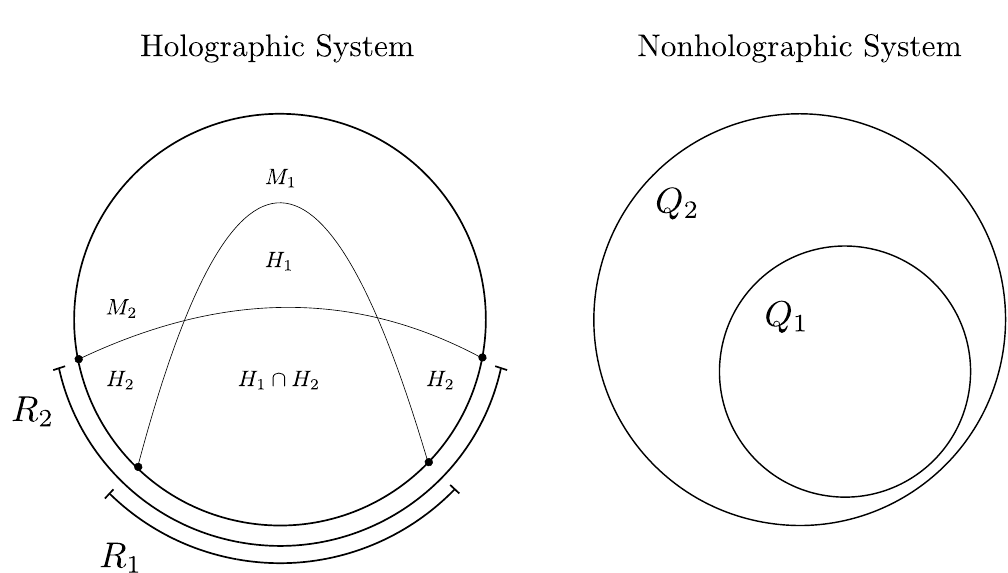
(cid:26) H R 1 ;Q 1 2 ;Q 2